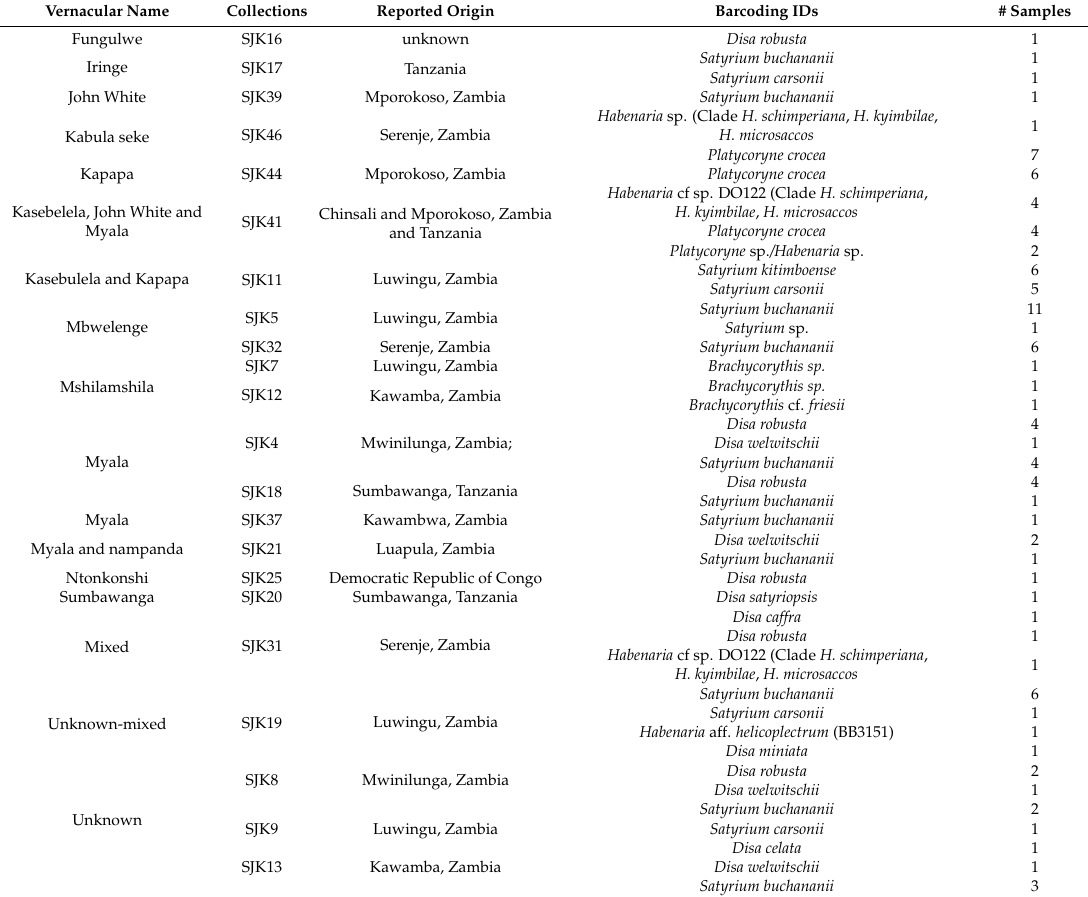
Table 1. Overview of the different local chikanda classification types, their collections and the identified scientific